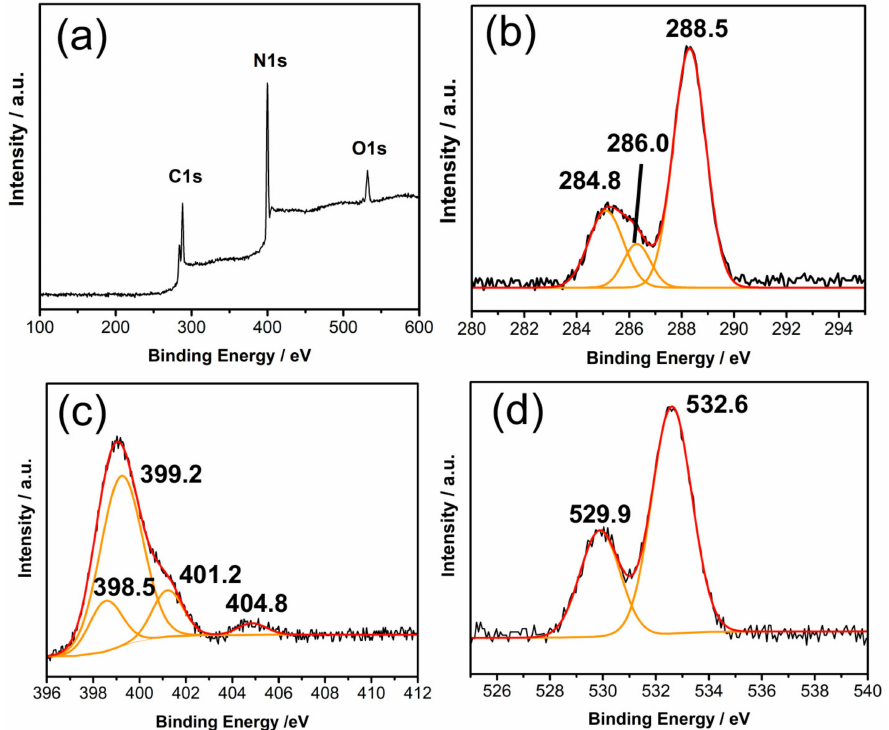
Figure 3. X-ray photoelectron spectroscopy (XPS) survey spectrum of 4CCN ( a ); the high-resolution XPS spectra of C 1s ( b ); N 1s ( c ); and O 1s ( d ). The black lines are the recorded XPS spectrum, while the red lines are the fitted curves of black lines, deconvoluted into the orange